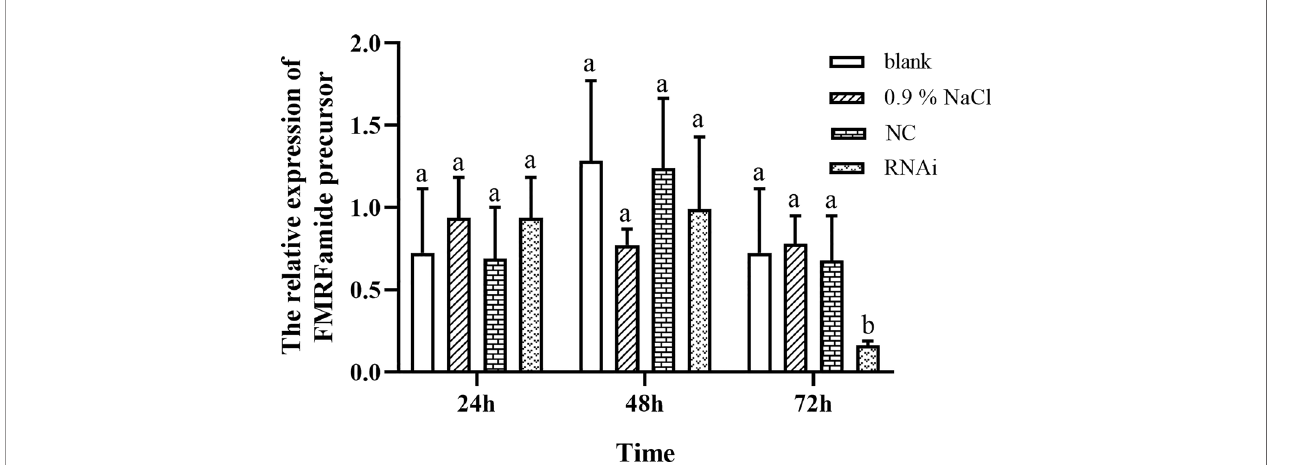
FIGURE 3 | FMRFamide precursor expression change in hemocytes after RNAi precursor. Data were analyzed by two-way ANOVA followed by Dunnett ’ s post-hoc test. The same letter indicates no signi fi cant difference ( p > 0.05); different letters indicate a signi fi cant difference ( p < 0.05). RNAi, RNA